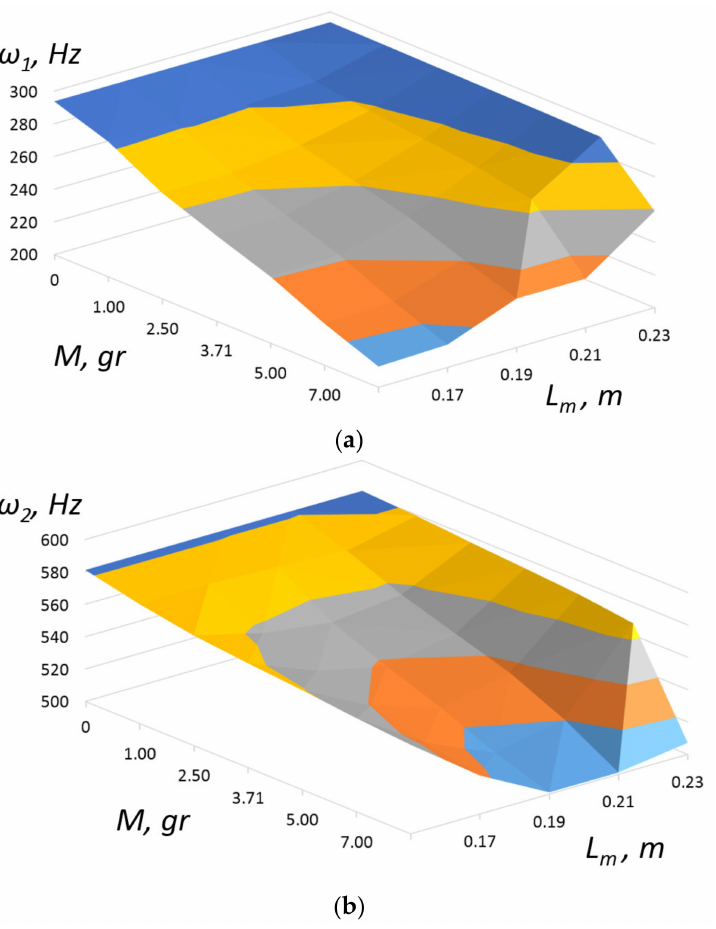
Figure 5. Dependence of 1 ( a ) and 2 ( b ) natural frequencies of PEG on the magnitude and location of proof mass at the lowest